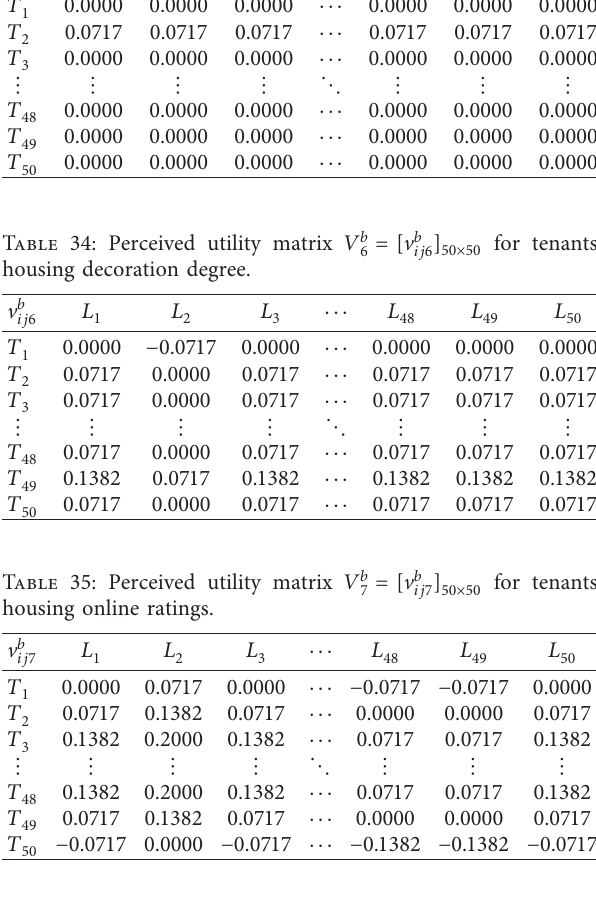
� [ v b ] for tenants’ ij 3 50 × 50 3